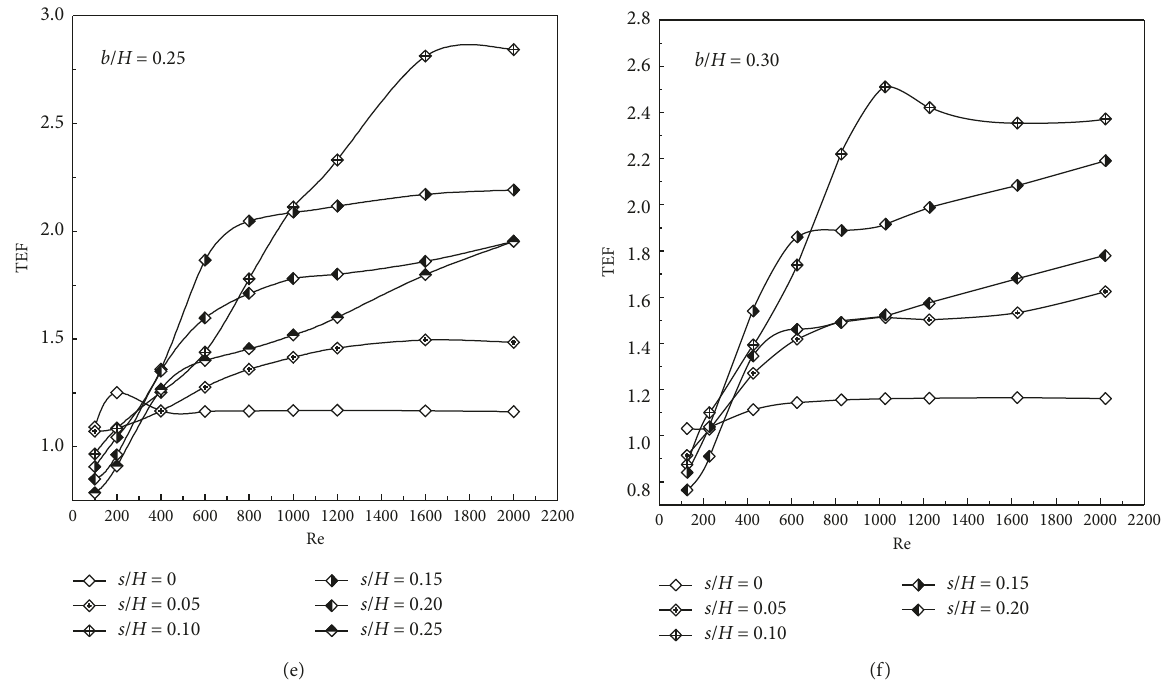
0.05, (b) b / H 0.10, (c) b / (cid:31) (cid:31)